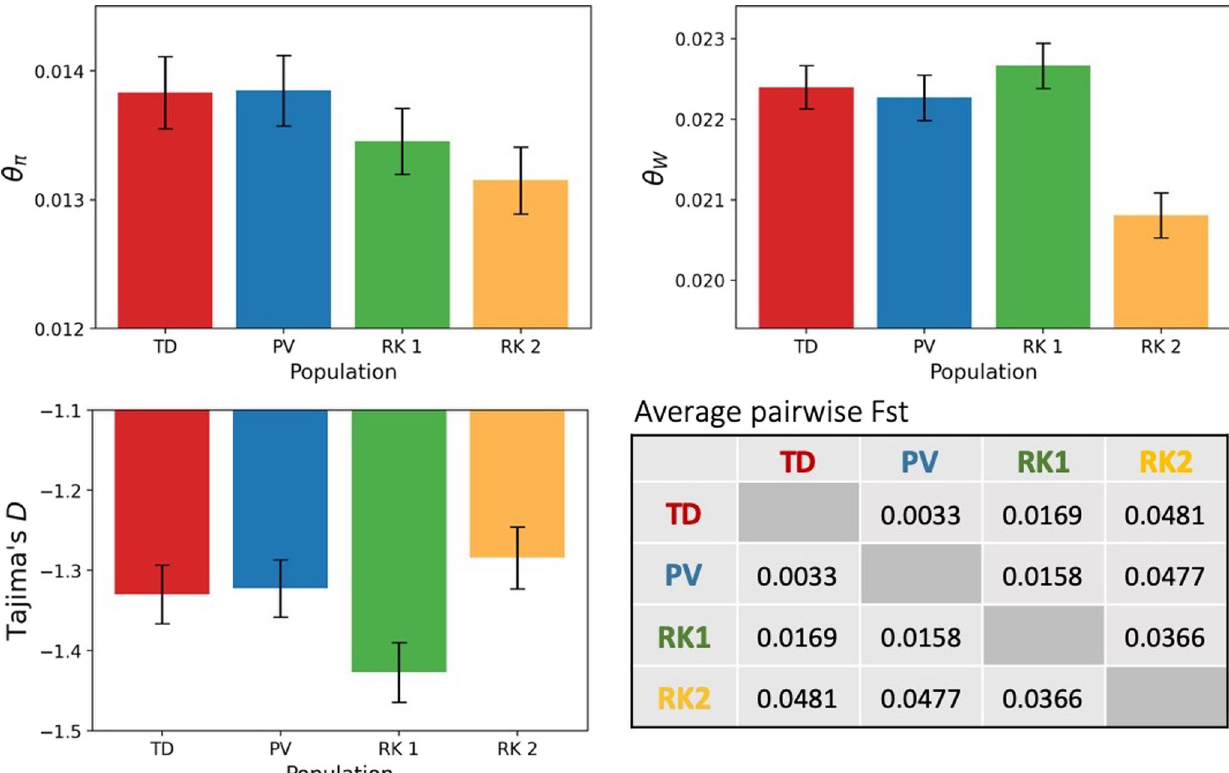
Fig. 2 Population diversity and divergence. Nucleotide diversity ( π ), Watterson ’ s Theta ( θ W ), and Tajima ’ s D statistics were calculated over fourfold degenerate sites on autosomal contigs. The error bars indicate 95% con fi dence intervals calculated over 100 bootstrap replicates over samples. An average pairwise Fst in the table here was calculated in 20 kb windows over the largest contig